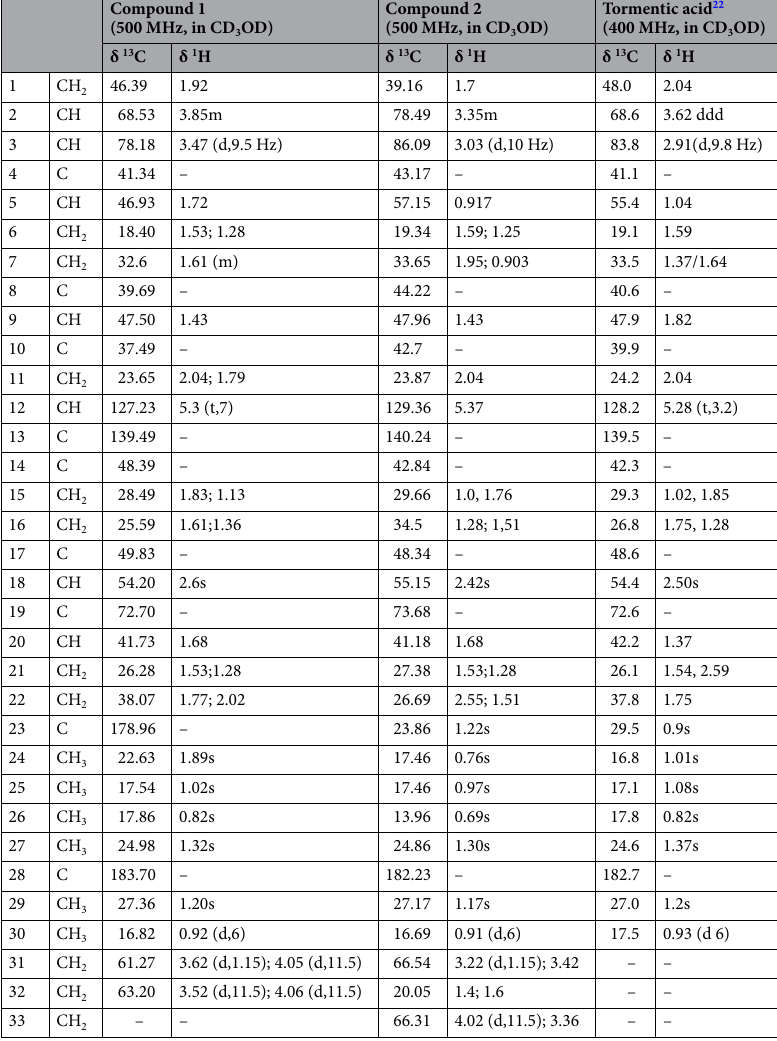
Table 1. 1 H and 13 C NMR spectra for compounds 1 and 2 . Data were measured in CD3OD (500 MHz).